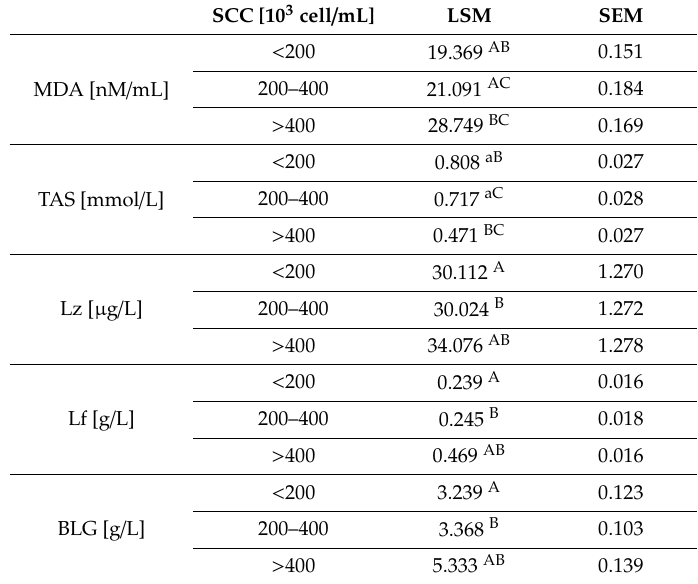
Table 1. Association of SCC with changes in whey proteins, MDA and TAS content.